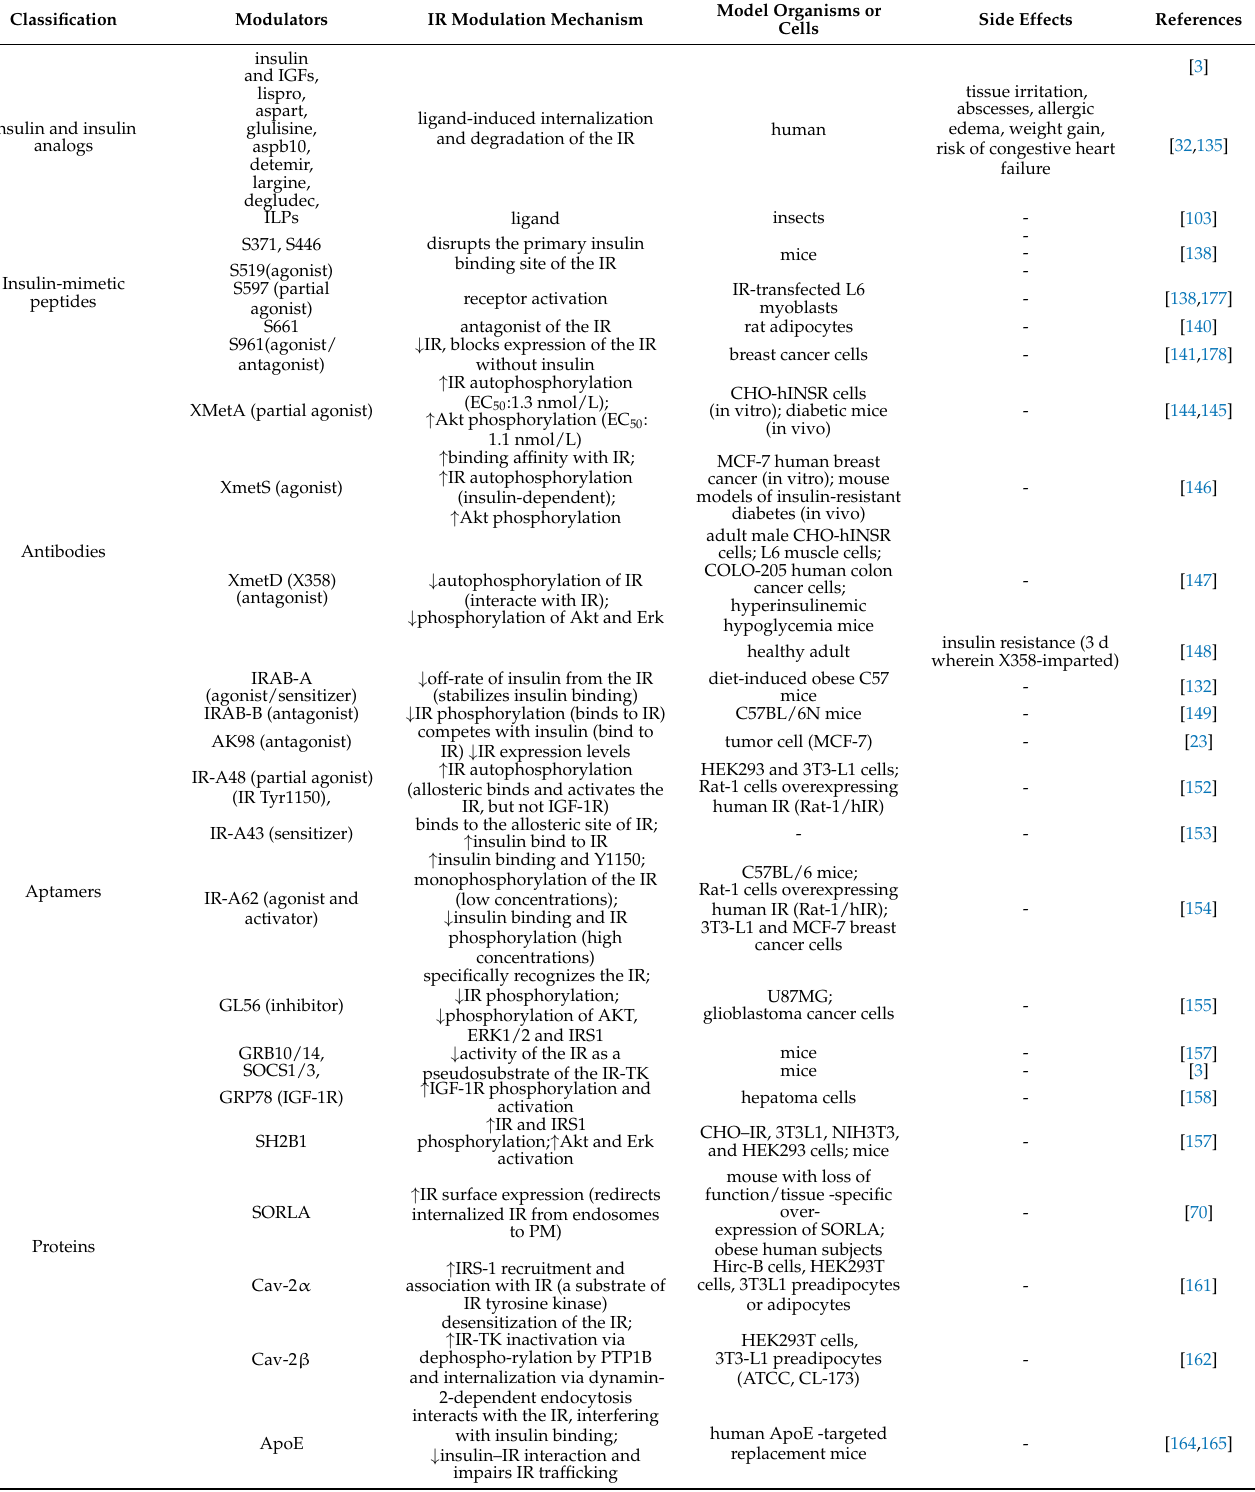
Table 2. Pharmacological and physiological modulators of IR